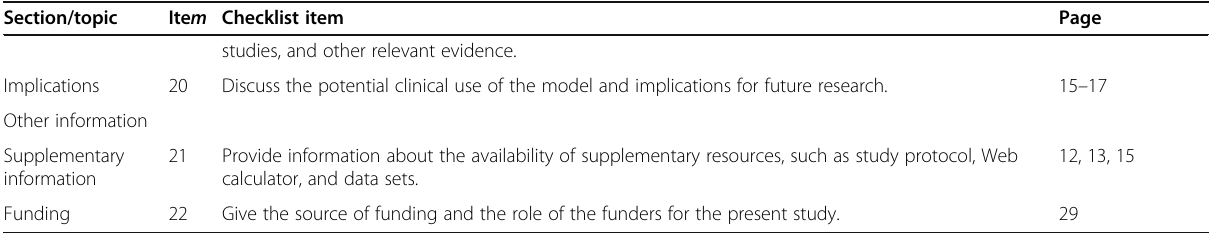
Table 3 TRIPOD checklist was followed for the development and the validation of the prognostic model (Continued)